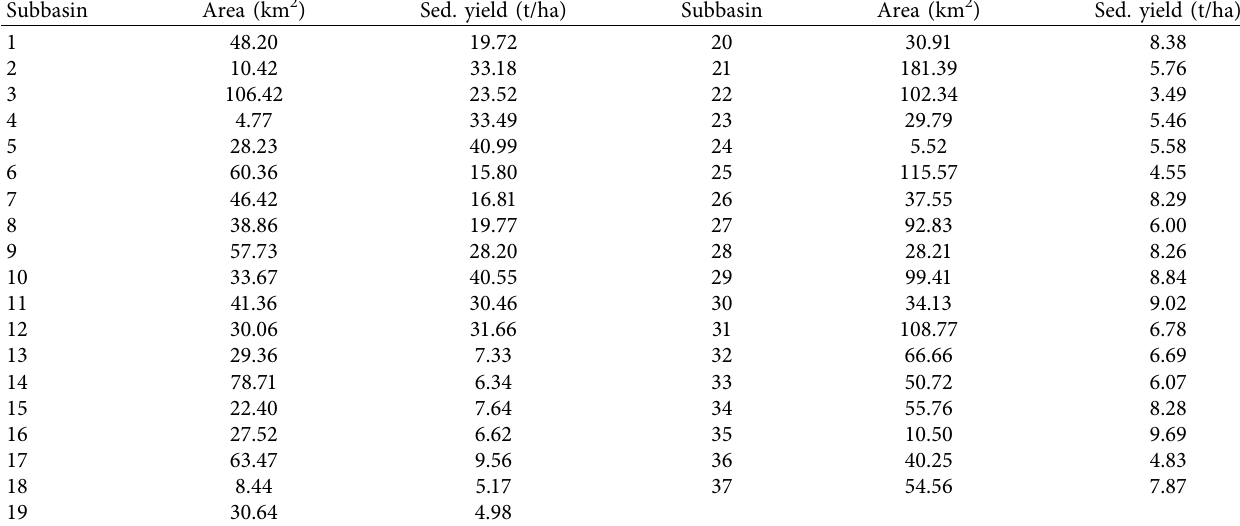
Table 11: The simulated sediment yield of the middle Awata watershed subbasins.